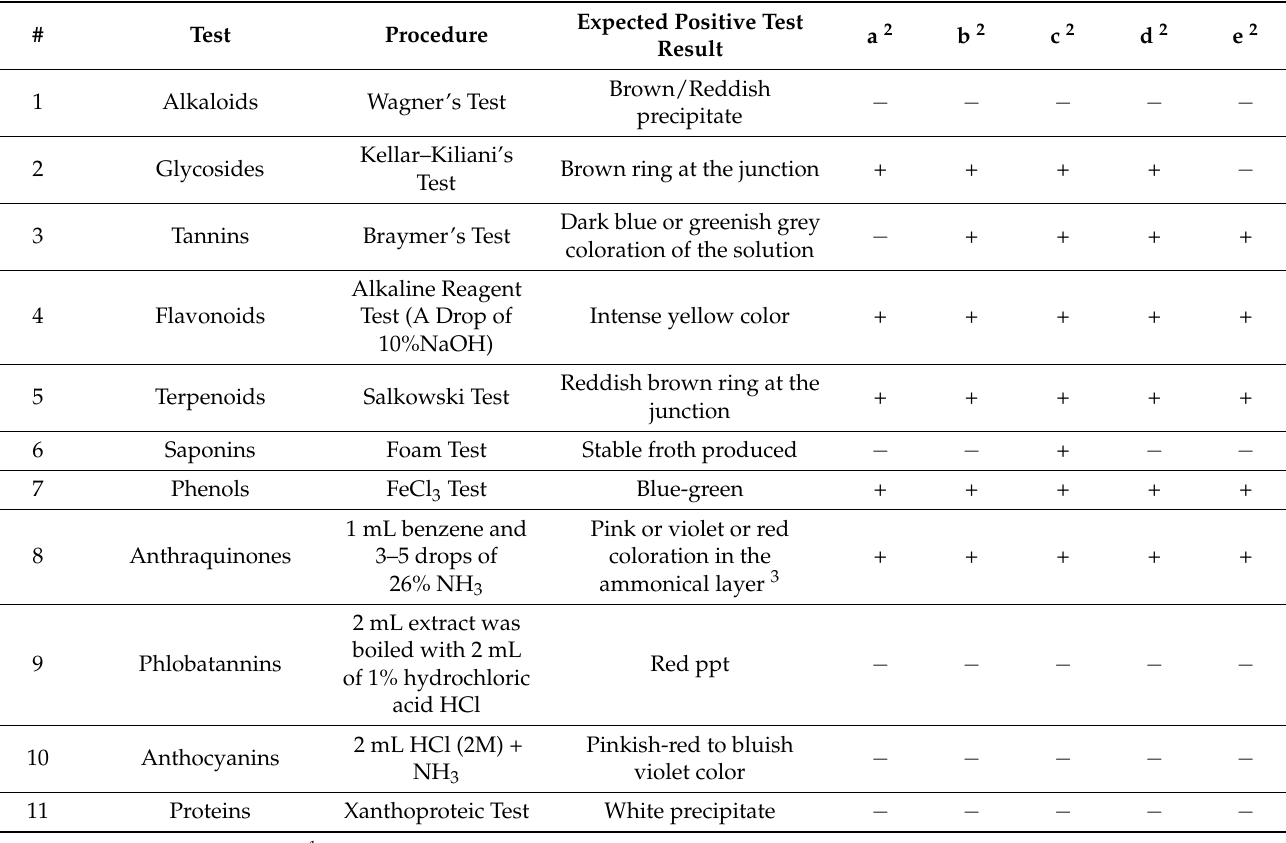
Table 1. The phytochemical analysis of Acacia ehrenbergiana grown in Qatar 1